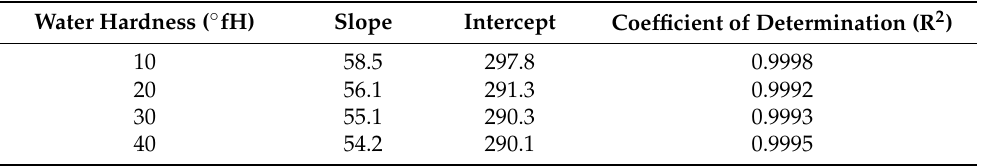
Figure 3. Chloride sensor’s linearity response in ( a ) 10 ◦ fH, ( b ) 20 ◦ fH, ( c ) 30 ◦ fH, ( d ) 40 ◦ fH solutions with different chloride content (5–100 mg/L). Table 1. Slope, intercept and coefficient determination values of the sensor’s calibration curves in solutions with different hardness and chloride content (see Figure